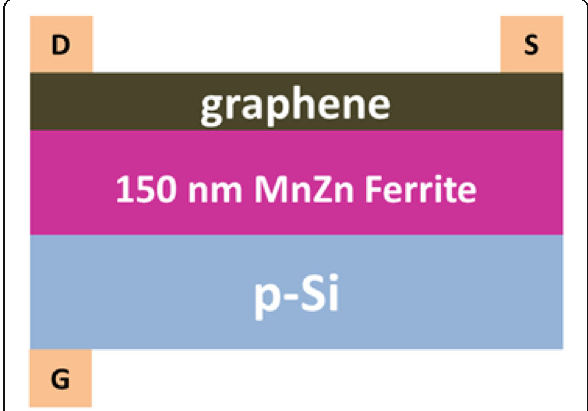
1 shows the XRD patterns of